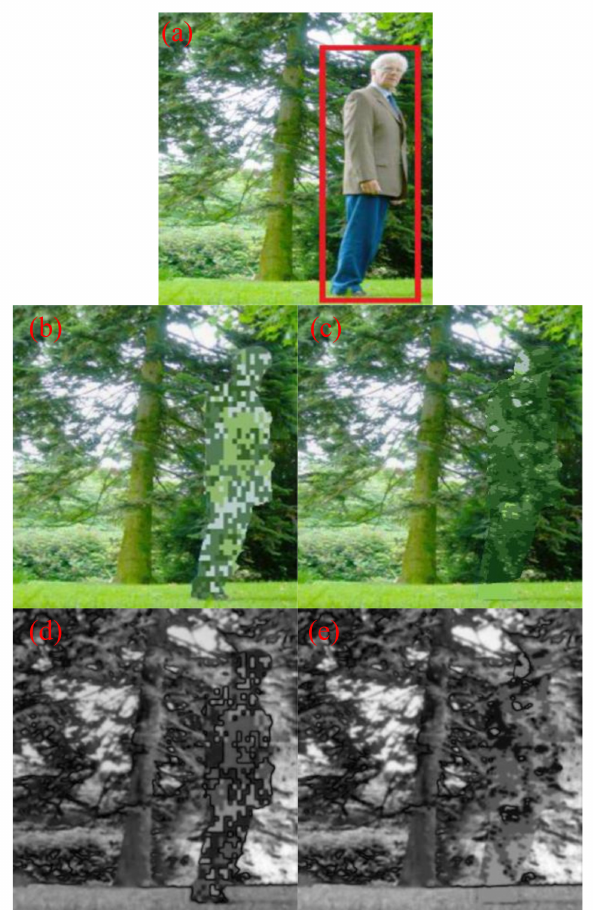
Figure 13. Comparison between our method and an existing method. ( a ) original image; ( b ) traditional camouflage texture; ( c ) adaptive camouflage texture; ( d ) the saliency map corresponding to image ( b ); ( e ) the saliency map corresponding to image ( c